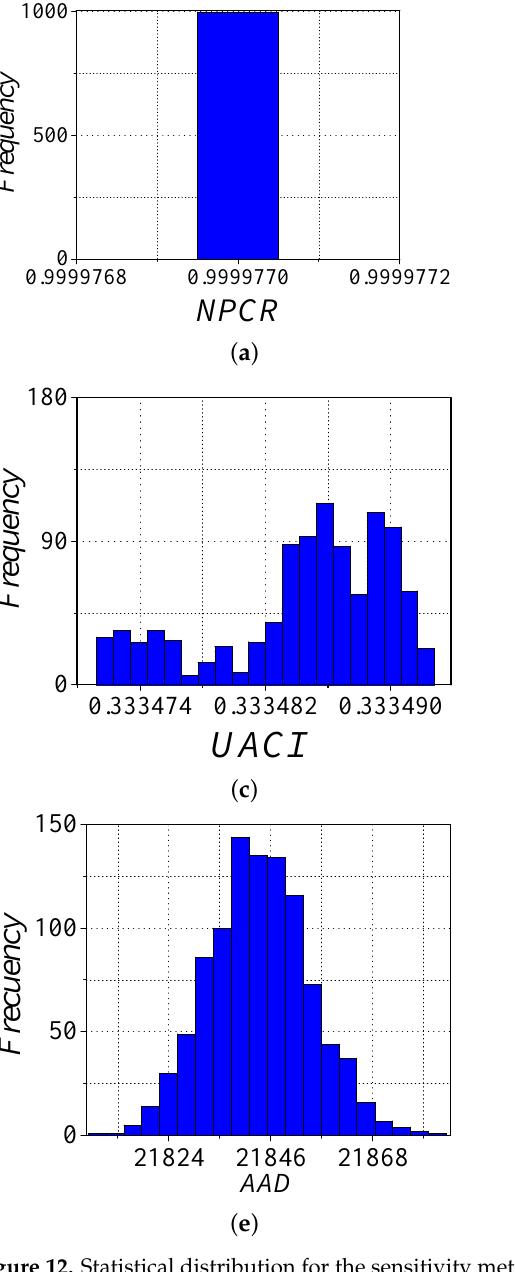
Figure 12. Statistical distribution for the sensitivity metrics estimated from 1000 pseudorandom sequences considering that the PRNG keys are very close to each other: ( a ) NPCR 16 ( p , q ), ( b ) NPCR 8 ( p , q ), ( c ) UACI 16 ( p , q ), ( d ) UACI 8 ( p , q ), ( e ) AAD 16 ( p , q ), and ( f ) AAD 8 ( p , q